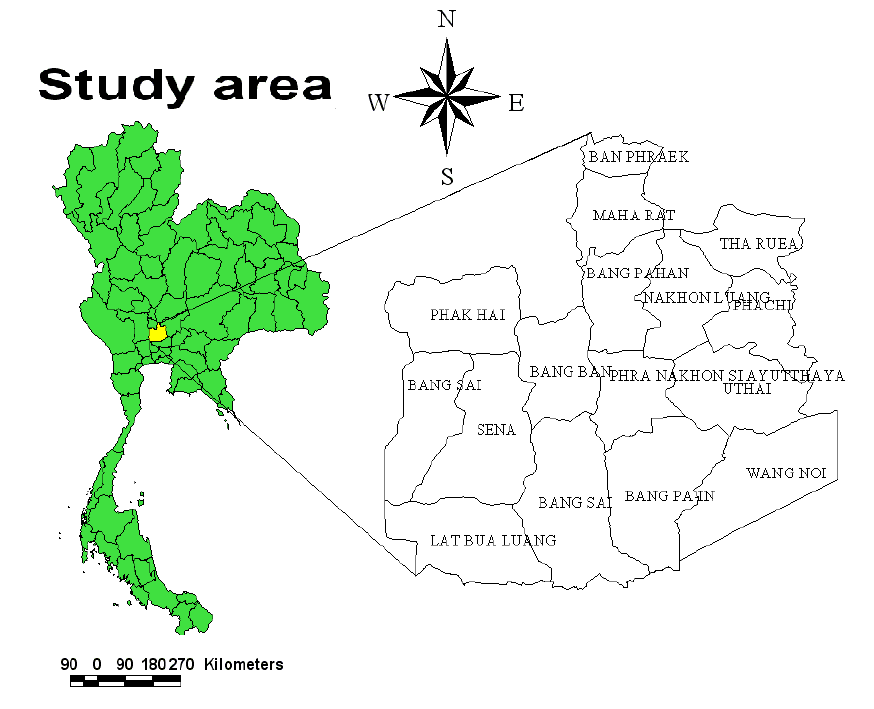
Figure 2. Location of study area in Ayutthaya province,